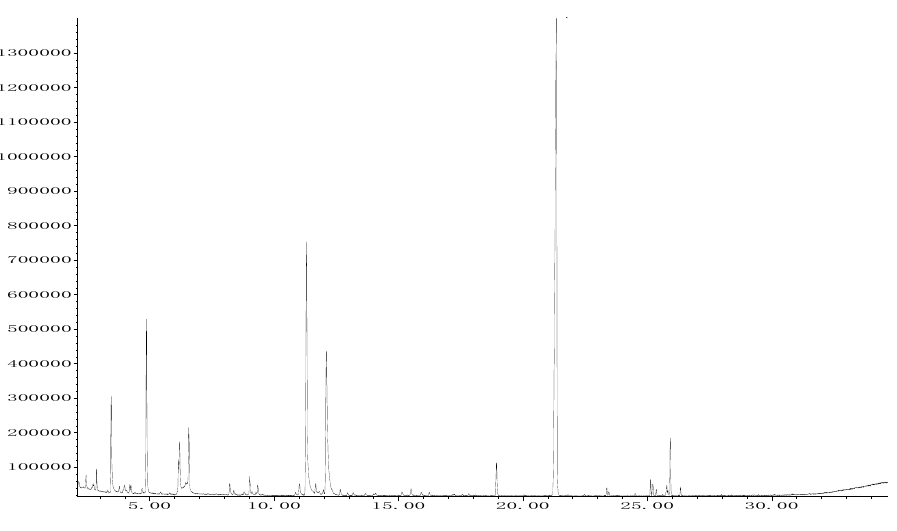
Figure 1. The total ion chromatograms of organic flavor compounds in FST 1 extracted with the four SPME fibers corresponding to Table